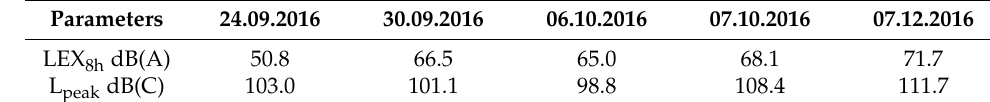
Table 3. Exposure levels measurements to noise sources.